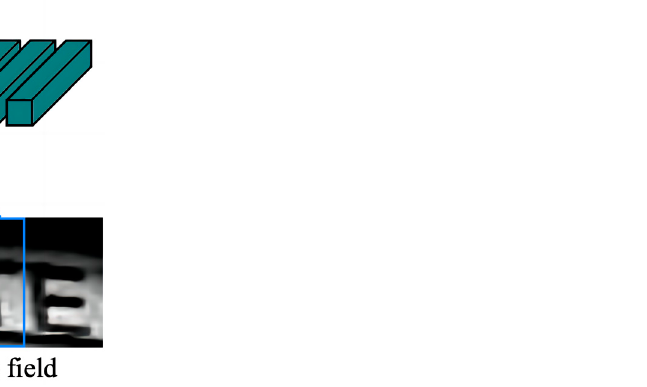
Figure 6. Receptive field. As each vector is associated with a receptive field on the input image, it can be considered as a feature vector of that field.